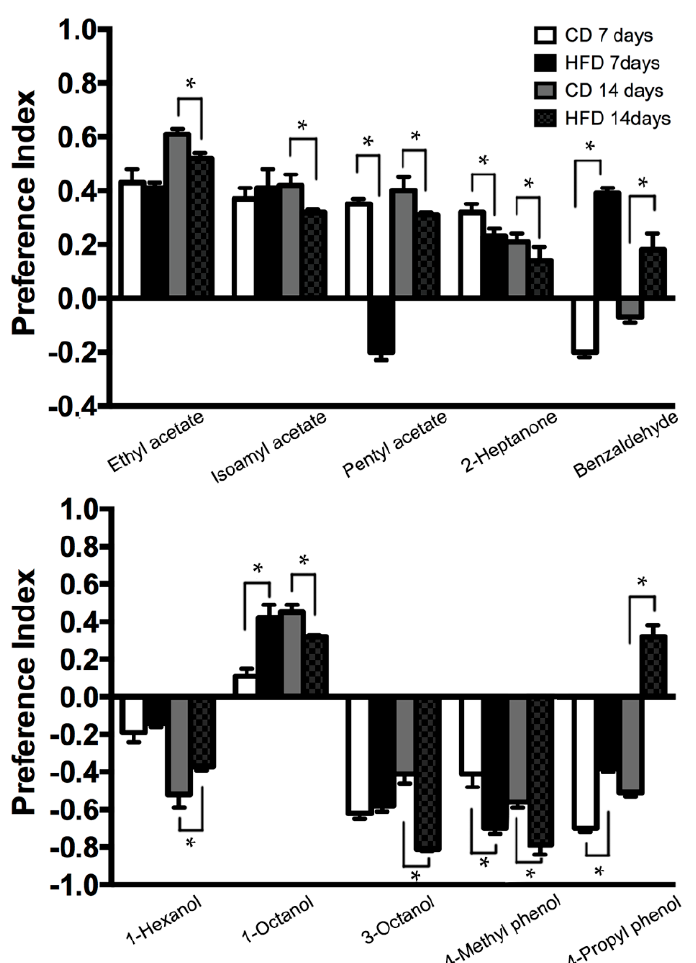
Figure 4. Alteration of attraction behavioral responses of wild type Canton-S flies fed with control diet and HFD for seven days and 14 days to several odors in a T-maze. Flies fed with HFD showed different responses in terms of attraction and repulsion to odorants compared with those fed with the control diet. 20 male flies were tested in each trial. The numbers of flies trapped in the control trap were indicated on the right side of the T-maze, while those in the test trap were indicated on the left side. * p < 0.05.